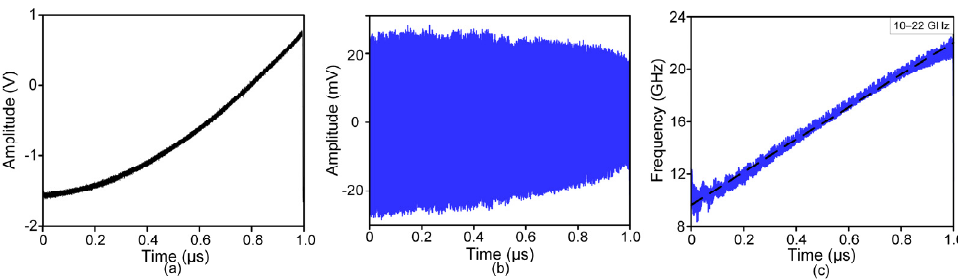
Figure 10. Results of the generated LFM waveform [45]. ( a ) Control signal S ( t ); ( b ) temporal waveform; ( c ) the recovered instantaneous frequency.